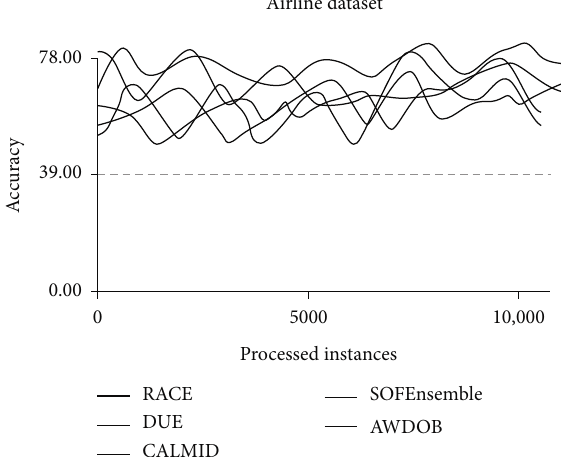
Figure 7: Prediction accuracy of the five algorithms on the Airlines dataset.